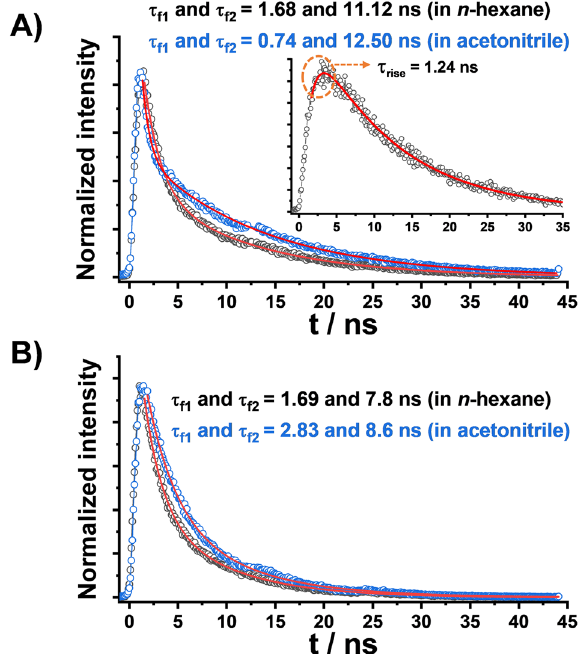
Fig. 2 Fluorescence decay pro fi les. A Fluorescence decay pro fi les of Anti - DPyB in n -hexane (black) and acetonitrile (blue), respectively. In A , the inset shows the fl uorescence decay pro fi le of Anti -DPyB measured at the long wavelength (500 – 600 nm) in n -hexane. The fl uorescence decay pro fi le of Anti -DPyB measured at the long-wavelength (500 – 600nm) shows a rise time of 1.24 ns as well as a decay time of 11.1 ns. B Fluorescence decay pro fi les of Syn -DPyB in n -hexane (black) and acetonitrile (blue),